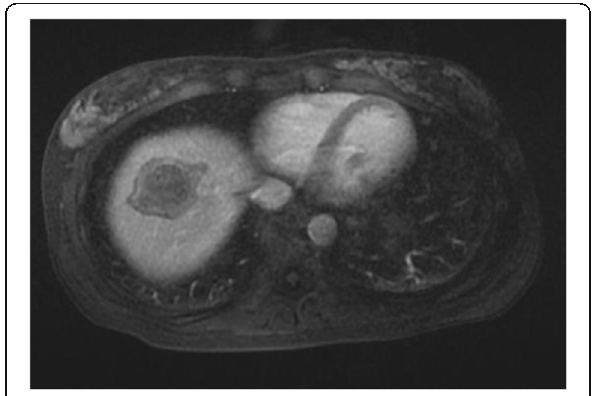
Fig. 2 EOB-MRI at 24 weeks of gestation. Non-enhancement of a 40-mm